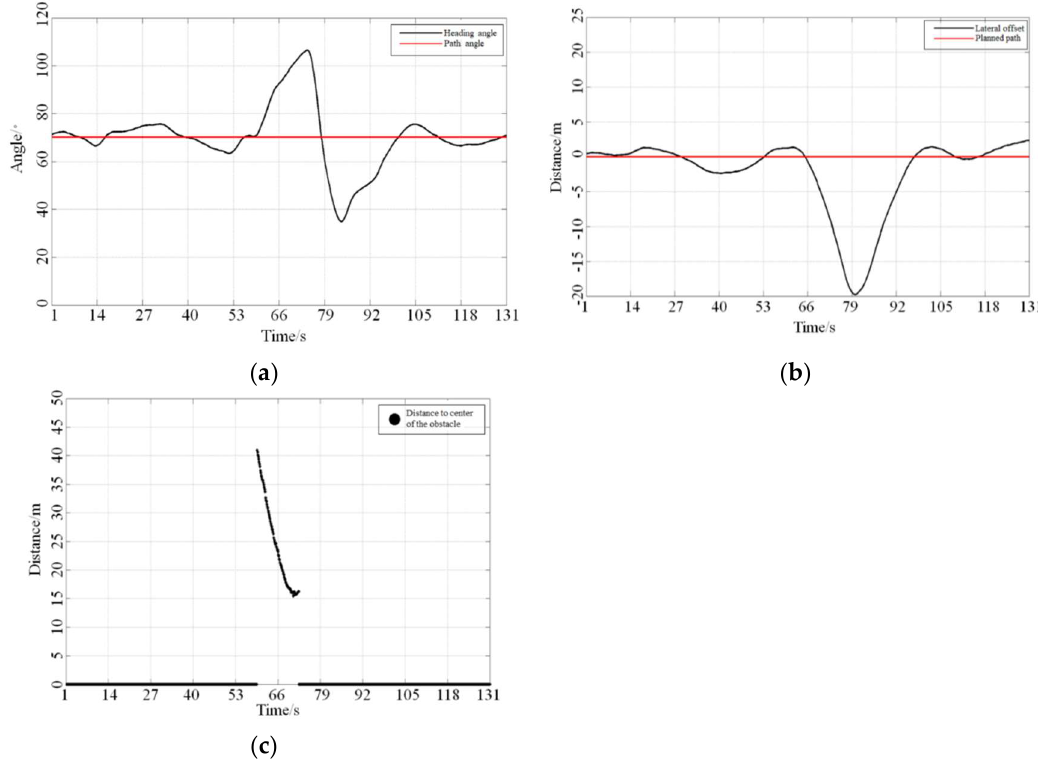
Figure 17. Collision avoidance results of the USV. ( a ) Changes in heading angle. ( b ) Changes in lateral offset. ( c ) Change in distance between the USV and the obstacle center.